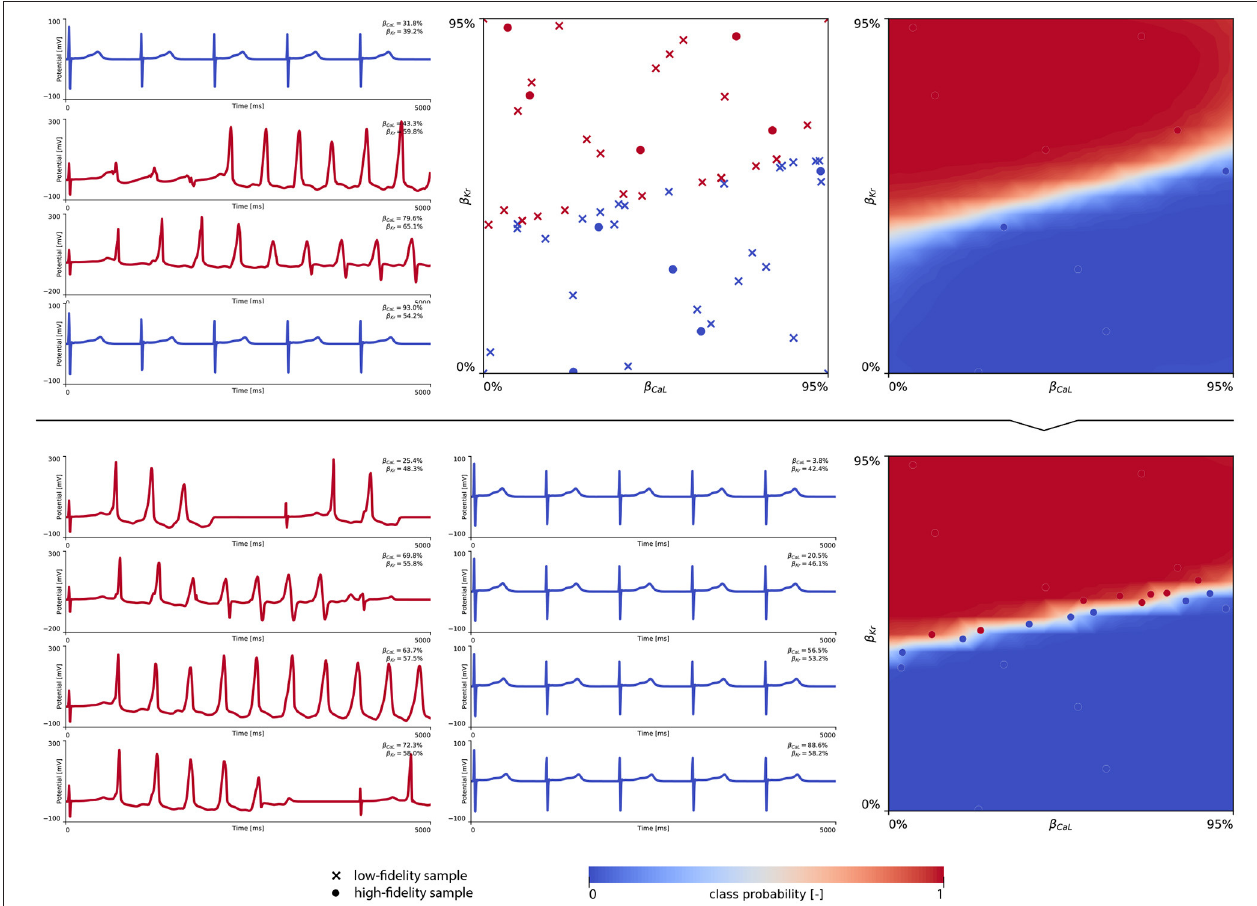
FIGURE 8 | Female multi-fidelity drug-induced arrhythmogenic risk classifier . (Upper) Initial exploration of the female drug-induced arrhythmogenic risk parameter space. The first 10 internal Latin hypercube samples of the B = { β Kr , β CaL } parameter space were evaluated for female drug-induced arrhythmogenesis, as showcased in the upper middle plot with “dot” markers. Here, the low-fidelity samples from training the low-fidelity female midwall Gaussian process classifier are shown with “x” markers. Virtual electrocardiograms of two arrhythmic and two non-arrhythmic { β Kr , β CaL } samples are shown in the upper left column plots. The resulting drug-induced arrhythmogenicity probabilities for the female heart is shown in the upper right plot. (Lower) Active learning exploration and exploitation of the female drug-induced arrhythmogenic risk classification boundary. The multi-fidelity Gaussian process classifier was trained further using 15 additional active learning high-evaluations of { β Kr , β CaL } effects. On the lower left, four additional arrhythmic sample evaluations are shown. The lower middle plot showcases four additional non-arrhythmic sample evaluations. The final female multi-fidelity drug-induced arrhythmogenic risk classification boundary is shown in the lower right